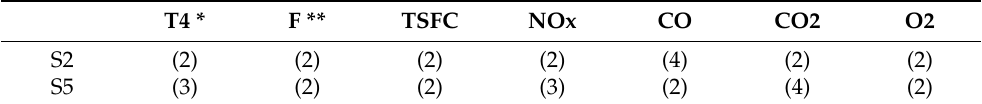
Table 4. Adopted alternative